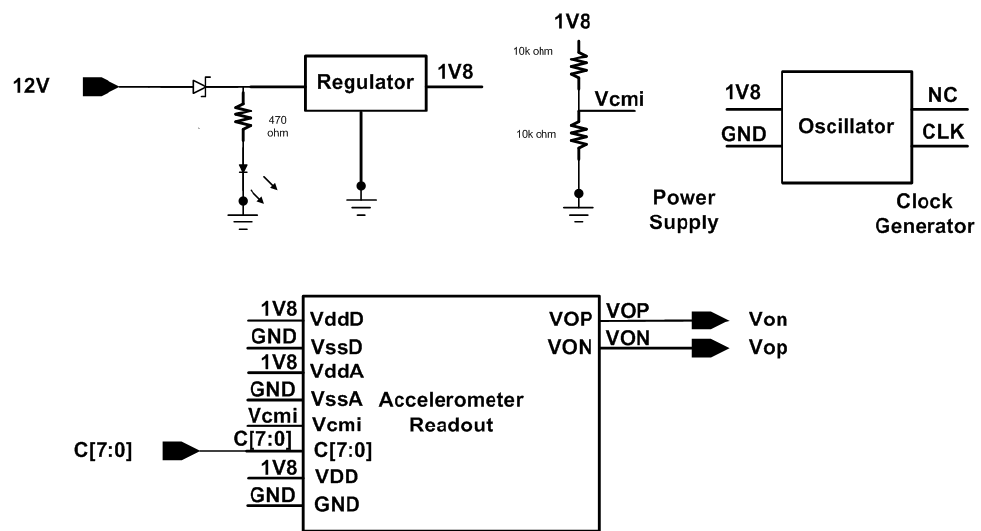
Figure 10. Simplified evaluation board schematics for accelerometer and readout circuit characterization.